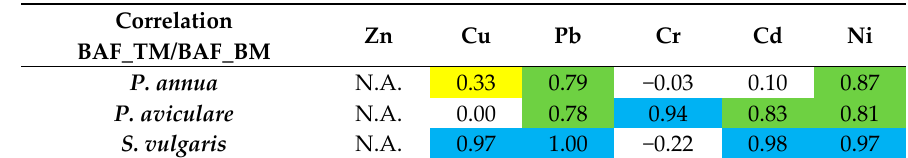
Table 4. Correlation table between BAF_TM and BAF_BM. Colors indicate the “goodness” of correlation: yellow = significant; orange = relevant; green = high; blue = excellent. Information about Zn was not available.